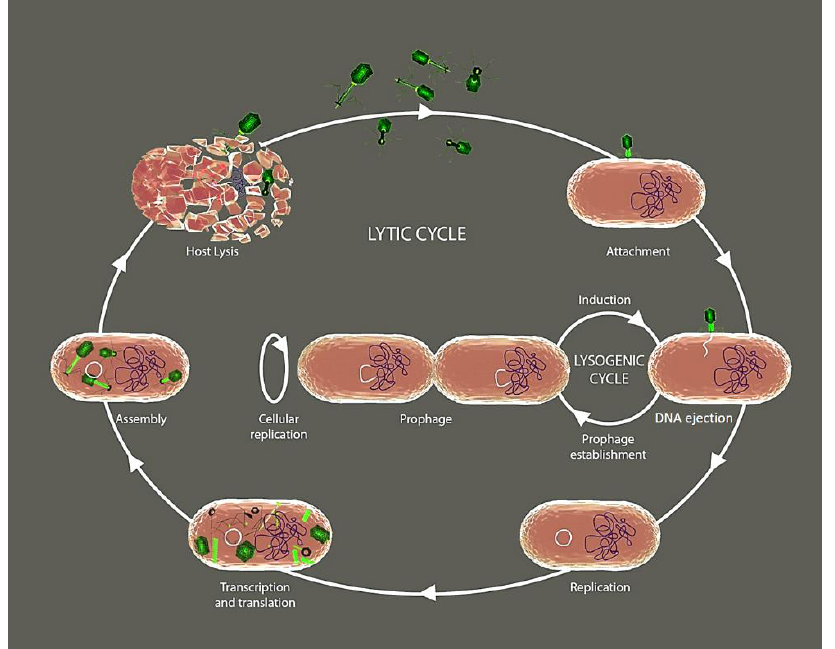
Figure 1. The lytic and lysogenic cycle of bacteriophages. The lytic cycle comprises a series of events from attachment of the bacteriophage to the bacterial cell membrane, to the release of daughter phages by the destruction of its bacterial host. In the lysogenic cycle, phage DNA integrates into the bacterial genome without major consequences for the bacterial cell, and where the nucleic acid of the virus replicates along with that of its host.